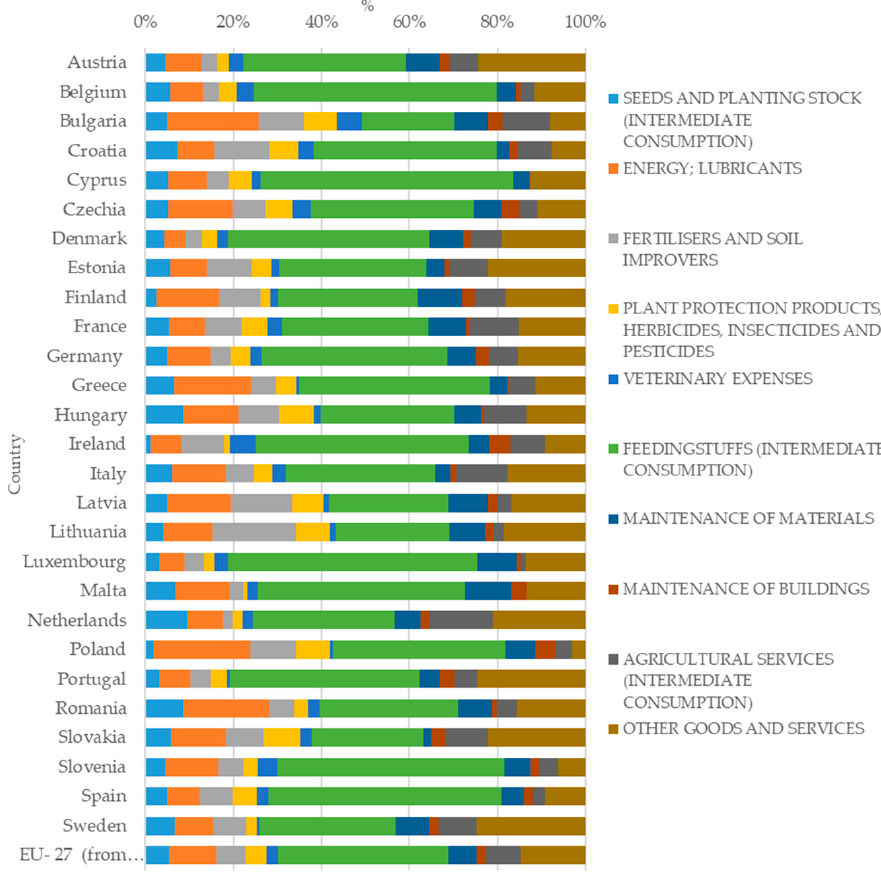
Figure 8. Total intermediate consumption structure for EU Member States, 2020. Source: Authors’ calculation and representation, according to Eurostat (2020) data. Table 11. Output/input ratio calculation based on economic results and consumptions (million euro)